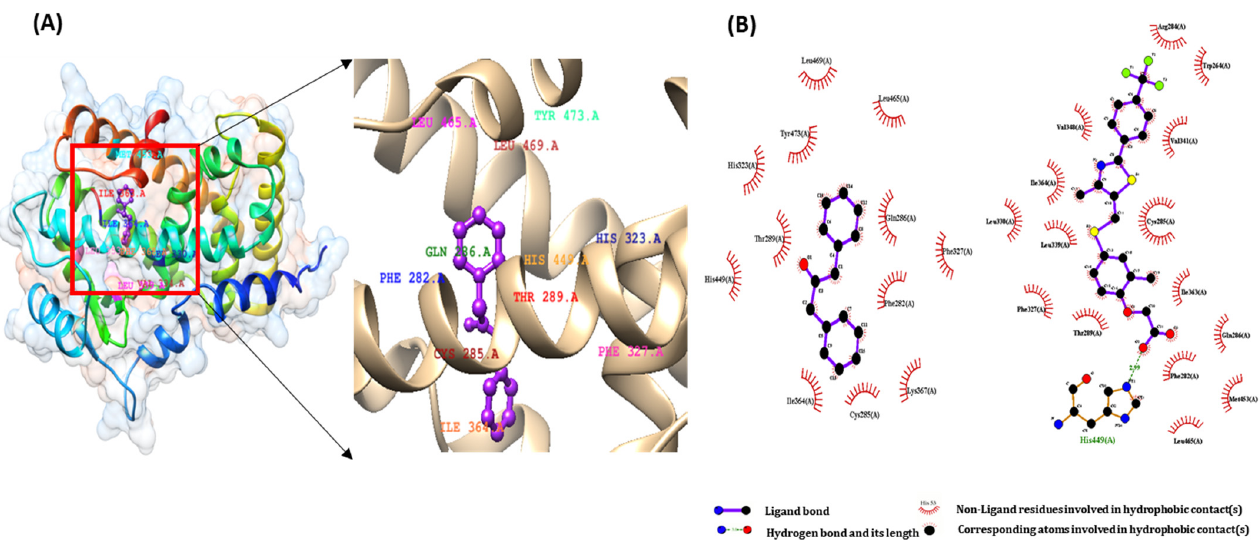
Figure 4. ( A )The binding interactions of 1,3-Diphenyl-2-propanone ligand with PPAR β protein ( B ) pharmacophore analysis between PPAR β and active components of 1,3-Diphenyl-2-propanone and PPAR β -GW501516 (control).